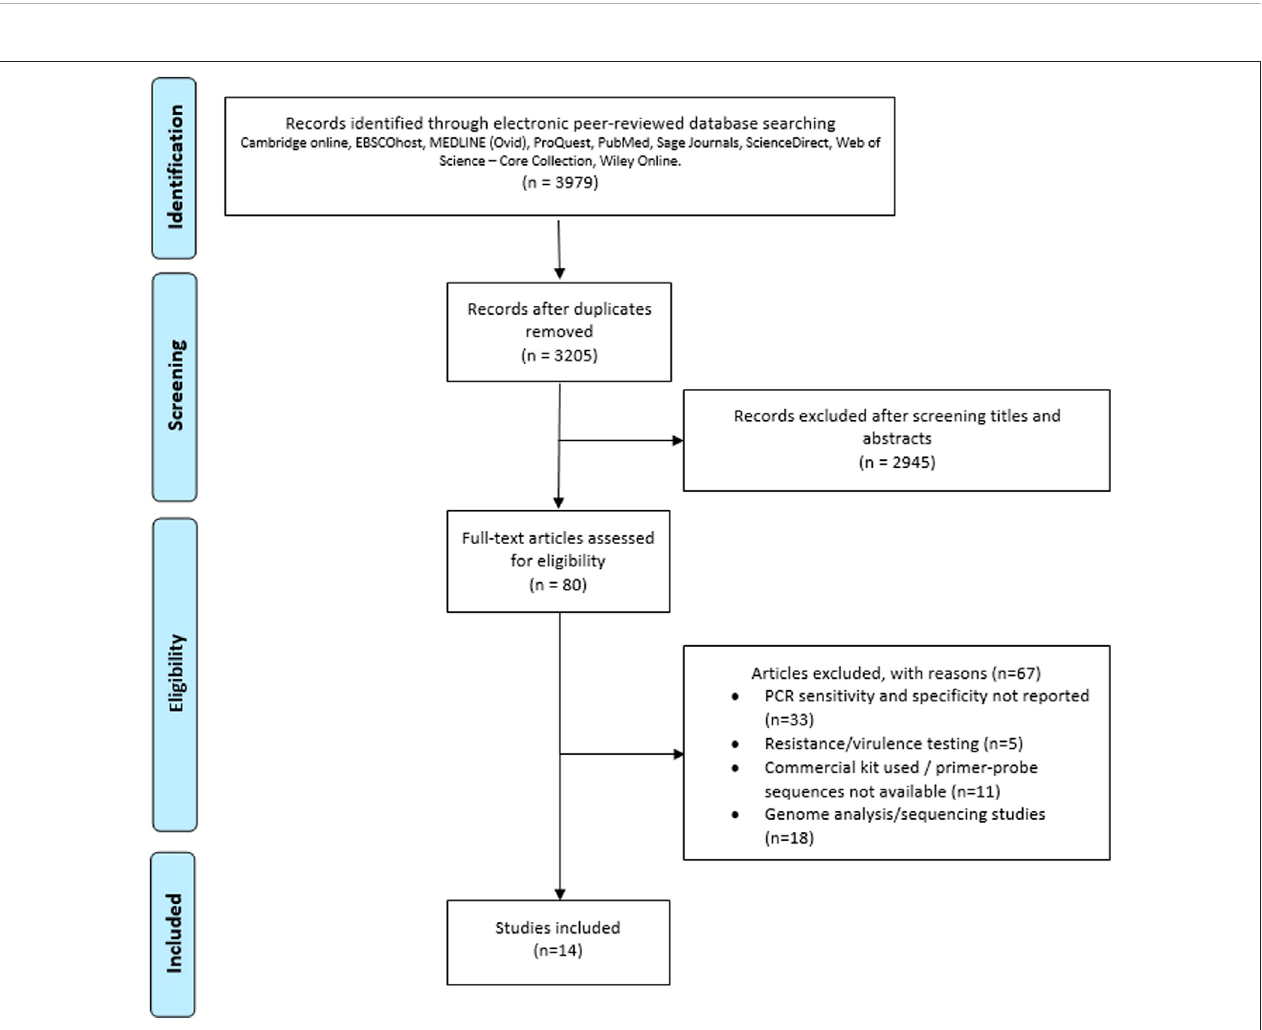
FIGURE1| PRISMA fl owchartofsearch,inclusionandexclusion screeningandaccepted studiesofthereviewoftheuseofPCRfordiagnosisand/or detectionof pathogens associated with bovine respiratory disease (Page et al., 2021).